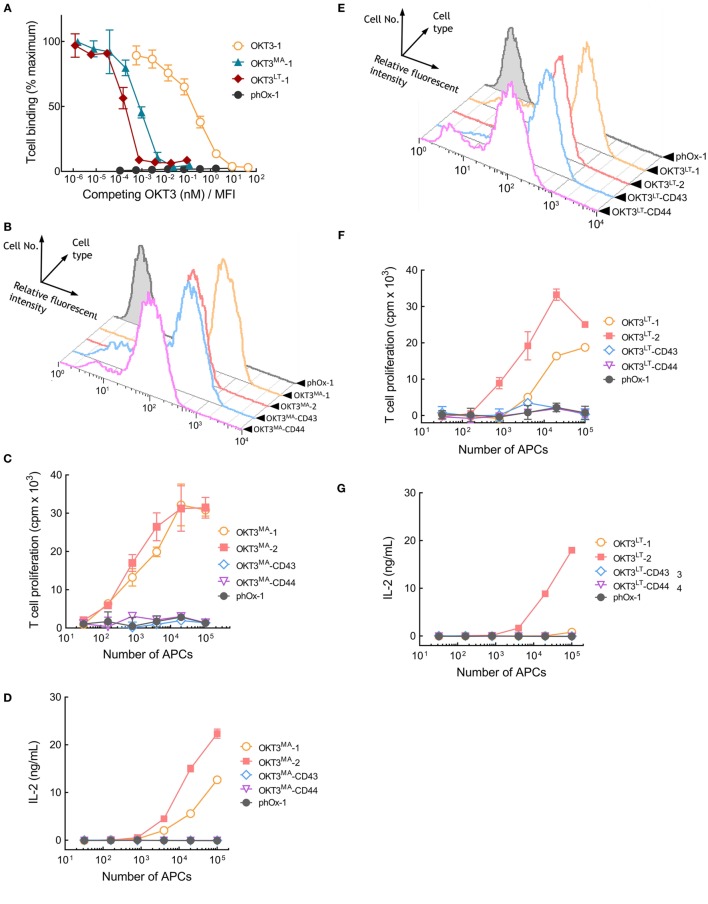
Membrane-tethered low-affinity OKT3 scFv activate T cells in a dimension-dependent manner. (A) Calcein-AM-labeled Jurkat T cells were incubated with monolayers of 3T3 antigen-presenting cells (APCs) expressing membrane-tethered OKT3 scFv (OKT3-1) or OKT3 variant scFv (OKT3MA-1 and OKT3LT-1) in the presence of defined concentration of soluble OKT3 IgG. The y-axis shows the mean fluorescence (n = 3) of bound T cells, whereas the x-axis represents the concentration of soluble OKT3 antibody added normalized for the level of each membrane-tethered scFv, as determined by mean immunofluorescence intensity of the 3T3 APCs stained with anti-HA antibody. Bars, SD. (B) The expression of membrane-tethered OKT3MA scFv on 3T3 APCs was determined by FACS. The proliferation as measured by the incorporation of 3H-thymidine into cellular DNA of the T cells (C) and IL-2 secretion (D) of 105 human peripheral T cells incubated for 48 h with the indicated numbers of OKT3MA or control phOx-1 APCs (n = 3), Bars, SD. (E) FACS of 3T3 APCs expressing membrane-tethered OKT3LT or control phOx-1 scFv. The proliferation as measured by the incorporation of 3H-thymidine into cellular DNA of the T cells (F) and IL-2 secretion (G) of 105 human peripheral T cells incubated for 48 h with the indicated numbers of OKT3LT or control phOx-1 APCs (n = 3), Bars, SD.